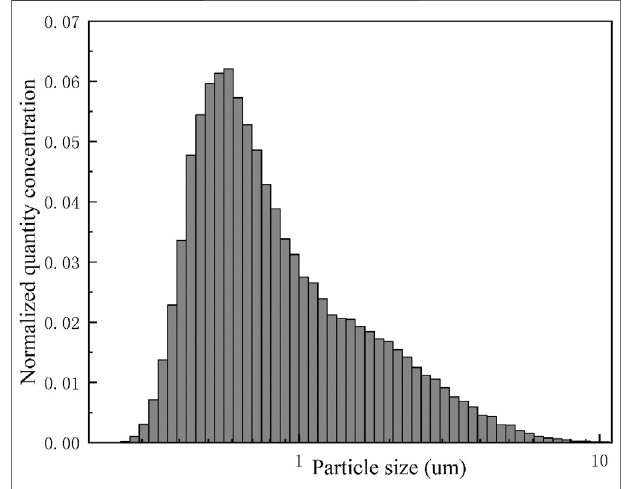
FIGURE 2 | Erosol particle size distribution. FIGURE 3 | Effect of the diluter on the measurement of